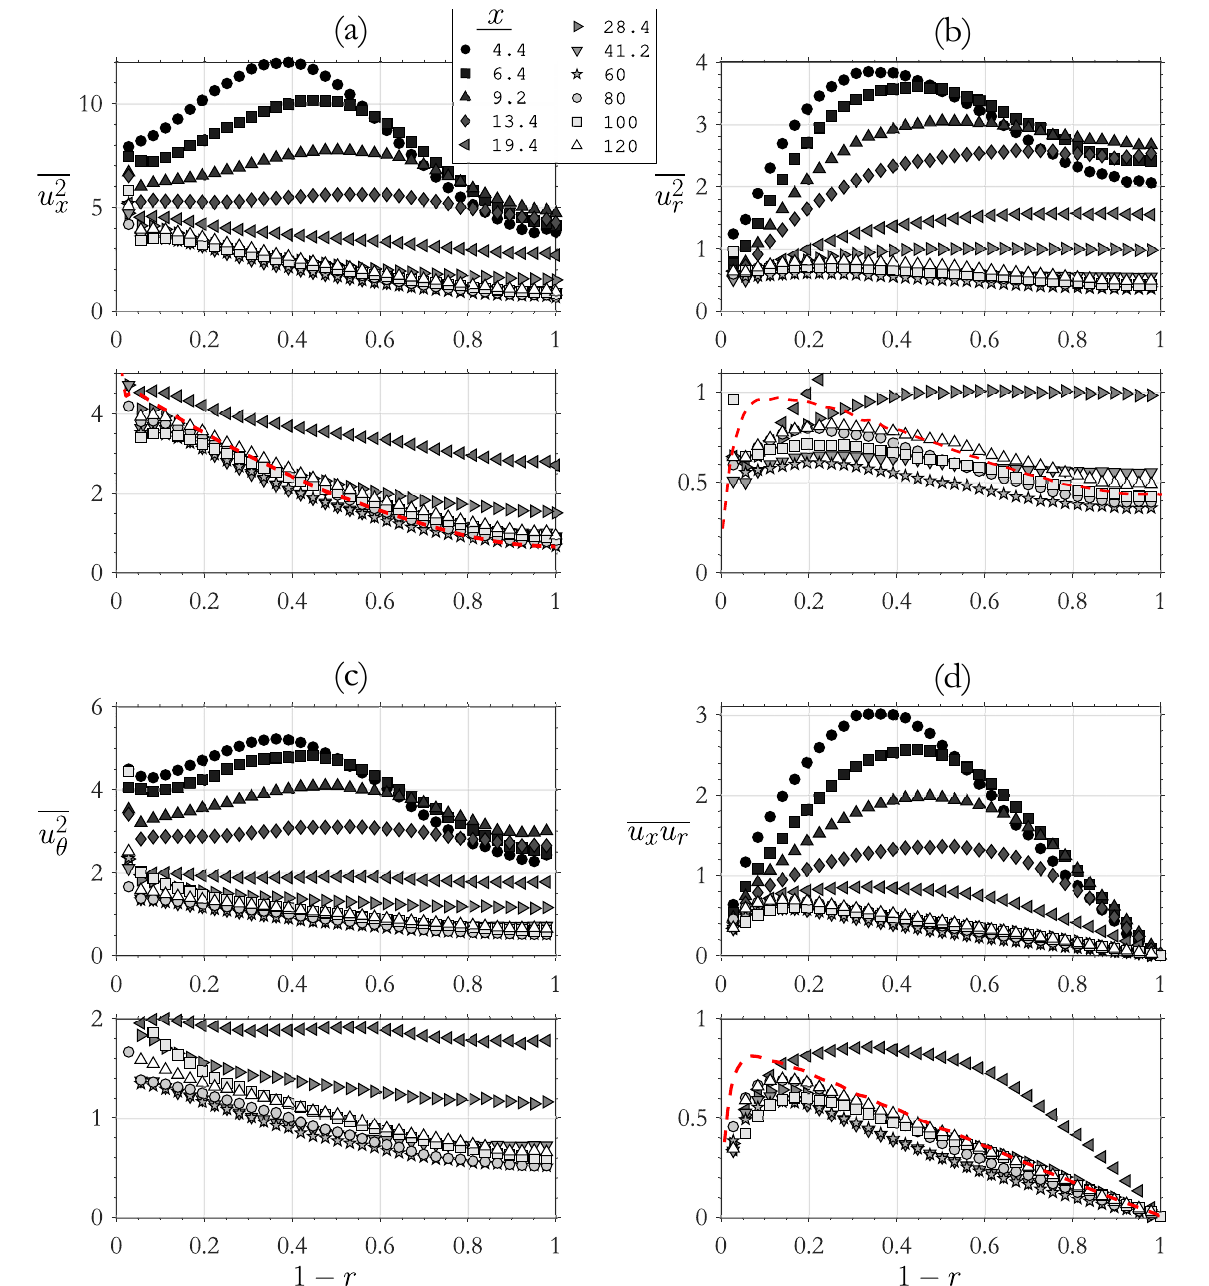
Figure 4. Downstream development of the Reynolds stresses in turbulent pipe flow responding to a change in surface roughness. The red dashed line marks the equilibrium profile. (Reproduced with permission from [37], published by Cambridge University Press